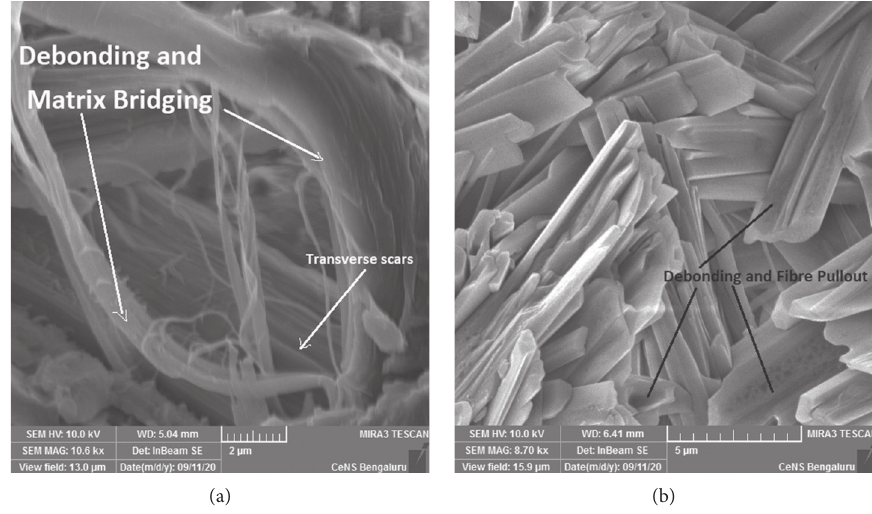
Figure 5: SEM of used jute epoxy composite with 12wt.% of graphite filler in the